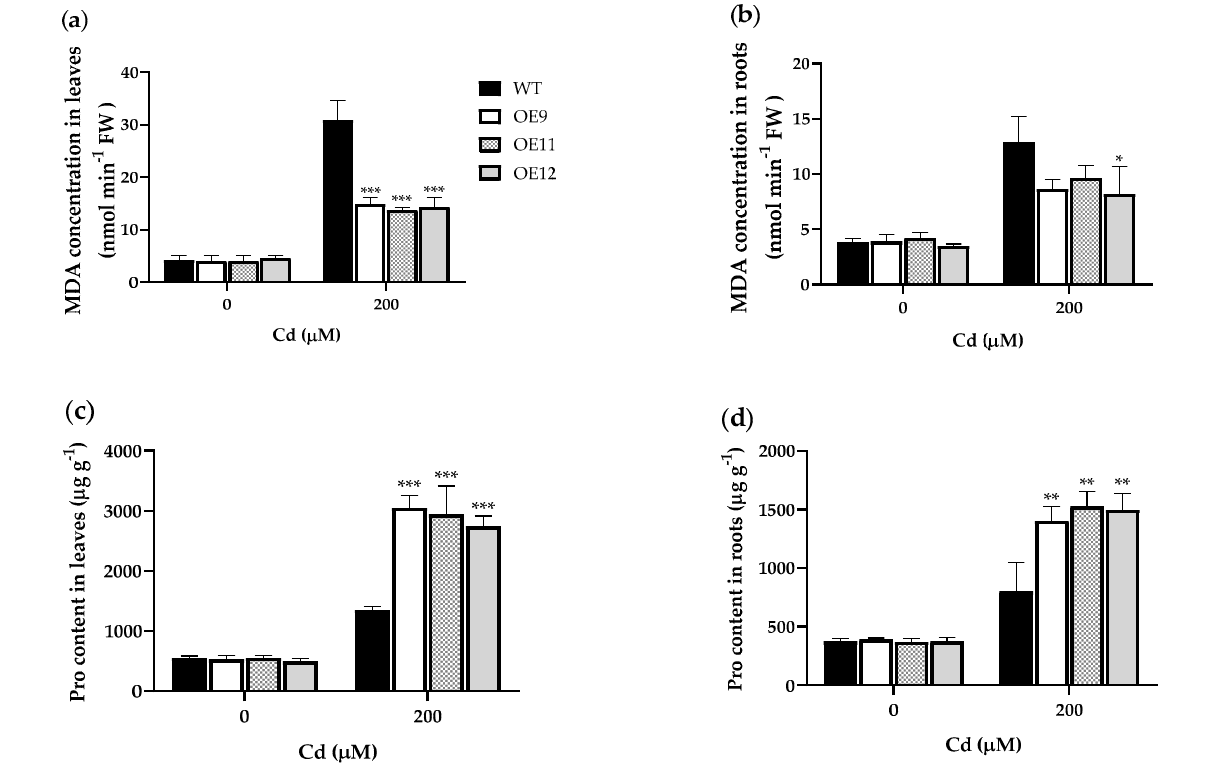
Figure 7. MDA and Pro content under 0 or 200 µ M Cd in wild-type (WT) and transgenic tobacco plants (OE9, OE11, and OE12). ( a ) MDA content in leaves ( b ) MDA content in roots. ( c ) Pro content in leaves ( d ) Pro content in roots. Data represent the means ± SD ( n = 3). Asterisks indicate a significant difference between the transgenic lines and the WT (*, p < 0.05; **, p < 0.01; ***, p < 0.001).